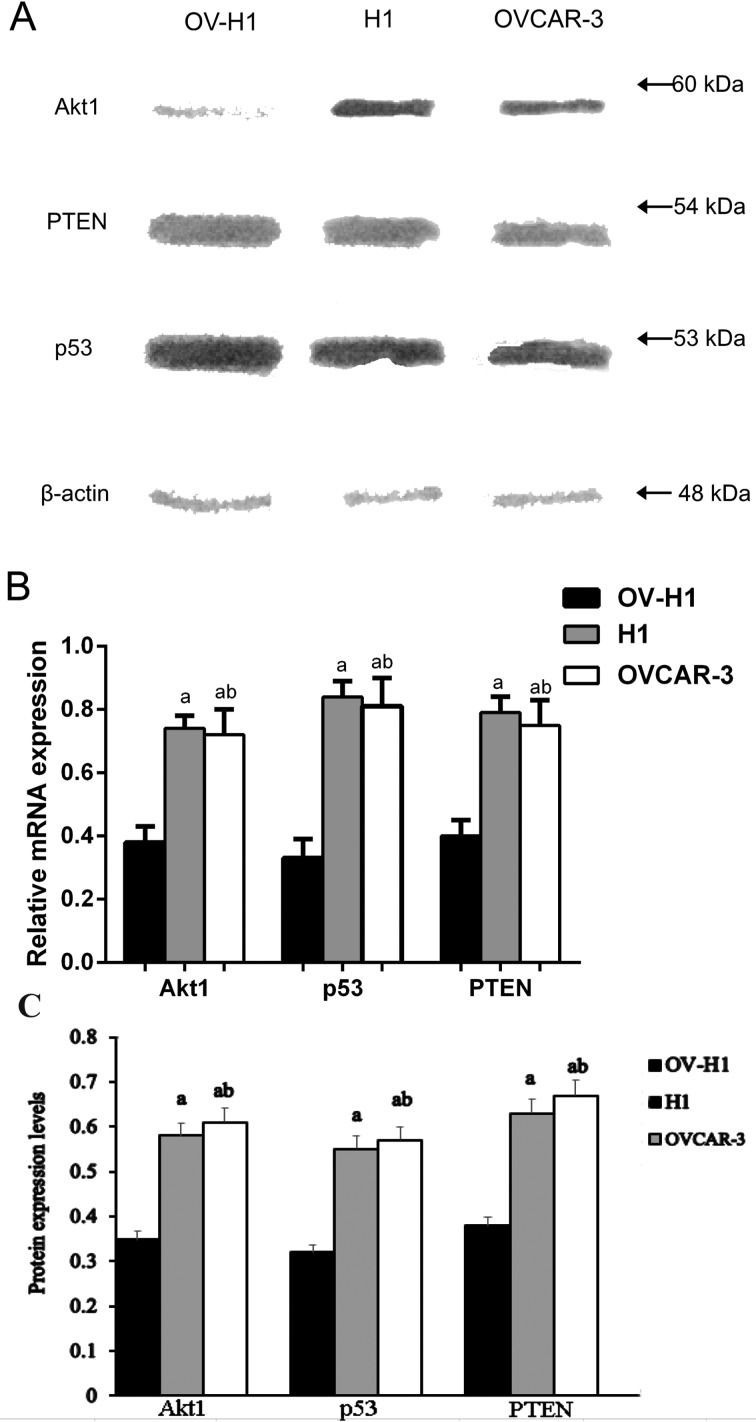
Quantitative RT-PCR and western blot results(A) Gel electrophoresis map showing the electrophoresis bands of Akt1, p53 and PTEN following PCR procedures. (B) The relative mRNA expressions levels of Akt1, p53 and PTEN were detected by real-time fluorescence quantitative polymerase chain reaction. (C) The protein expressions of Akt1, p53 and PTEN were detected by Western blot. Note: a, compared with the OV-H1 hybrid cells, P< 0.05; b, compared with the values between hESCs and OVCAR-3 ovarian cancer cells, P>0.05.